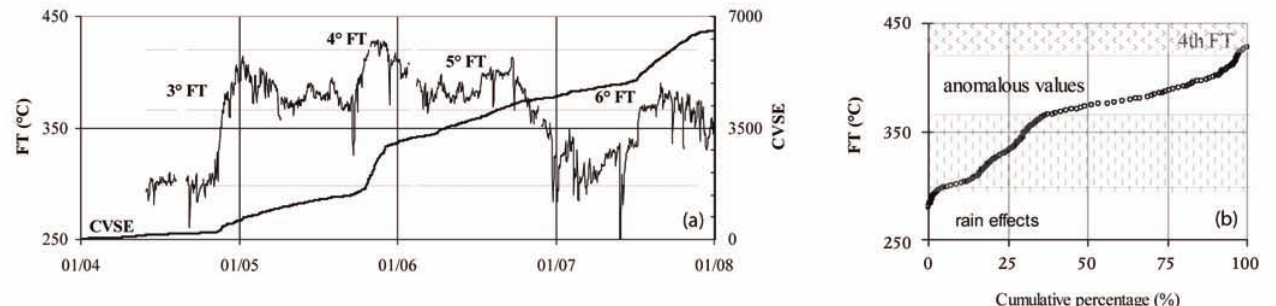
(km).N° Table 2. Main characteristics of the seismic swarm that occurred in November 1998 [Diliberto et al. 2007]. M d : magnitude; RMS: root mean square error of residual travel time (s); ERH: horizontal error; ERZ: vertical error; H: focal depth